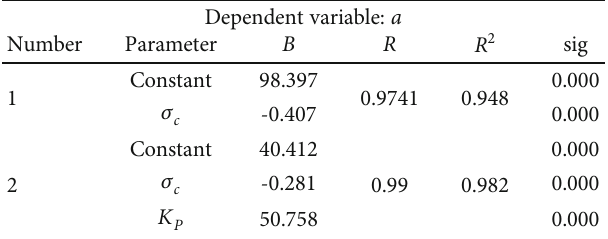
Table 5: The multifactor regression analysis model coe ffi cient of the chiseling speci fi c energy.